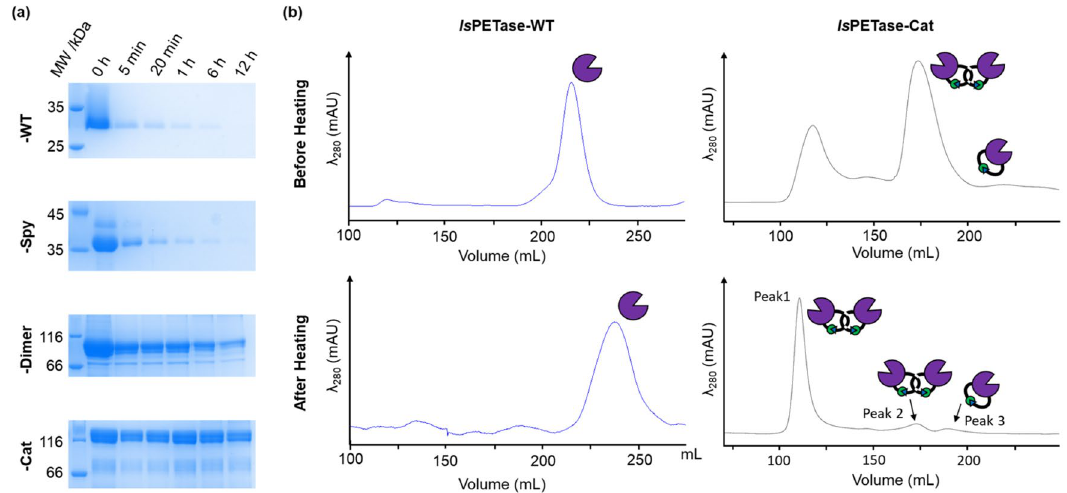
Figure 6. Analyses of Is PETase sample supernatant after heat treatment and centrifugation. ( a ) SDS-PAGE analysis of the linear and cyclic Is PETase variants after heating at 50 °C for increasing lengths of time (see Figure S10b for the original gels). ( b ) SEC chromatograms of Is PETase-WT and -Cat before and after heating at 50 °C for 5